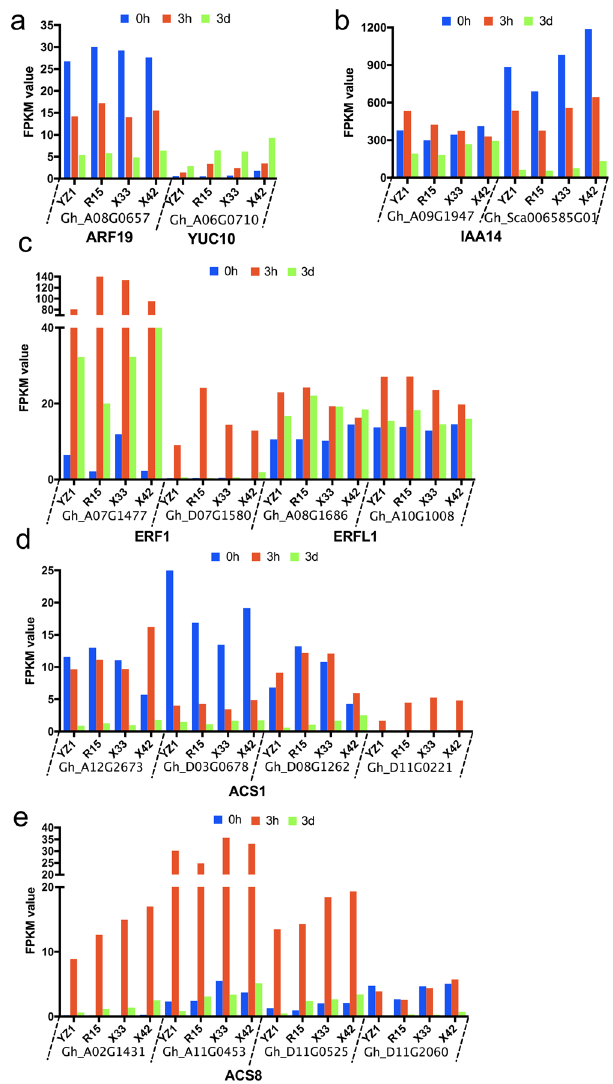
Figure 8. Expression of auxin ( a – c ) and ethylene ( d – h ) related genes at three time stages, 0h, 3h and 3d, in the two cultivars, HD and